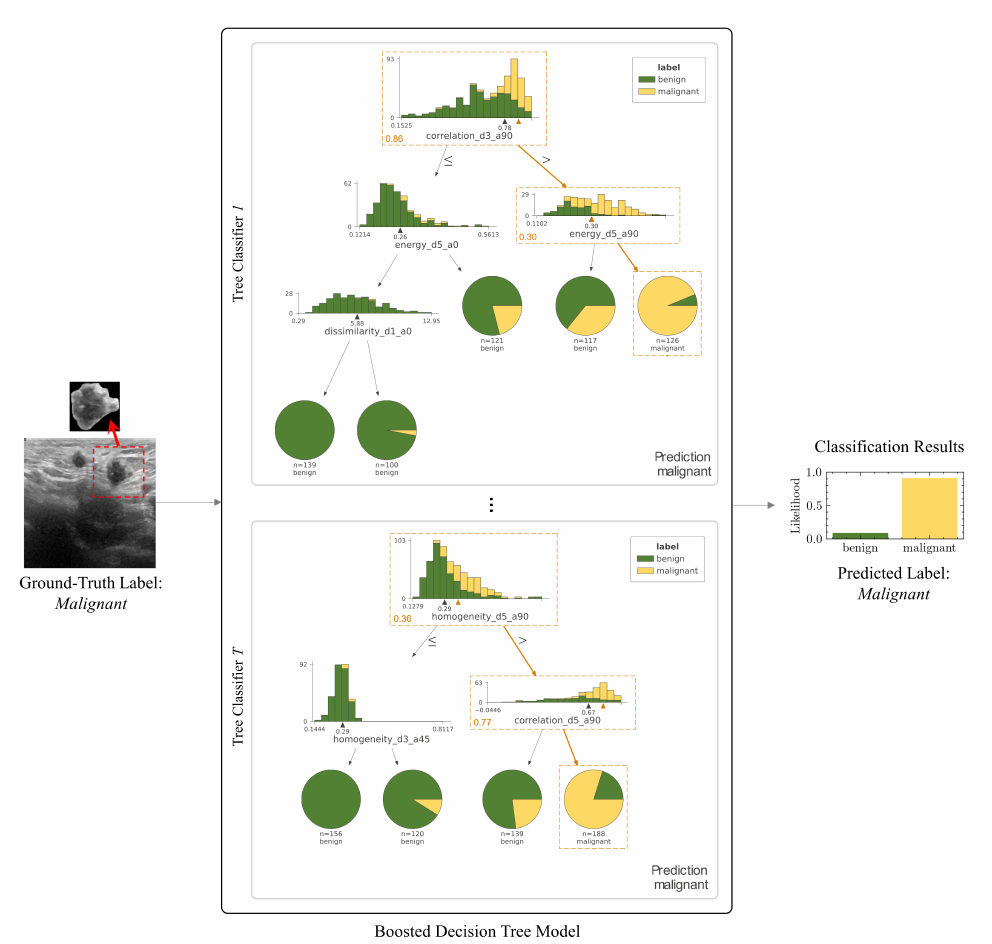
Figure 6. Qualitative results of a malignant case. Refer to the Figure 5 caption for more